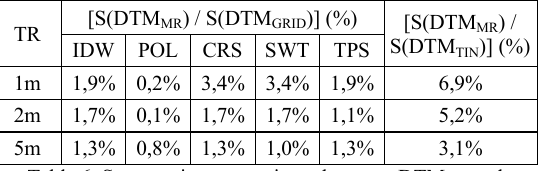
Table 6. Storage size comparisons between DTM MR and DTM